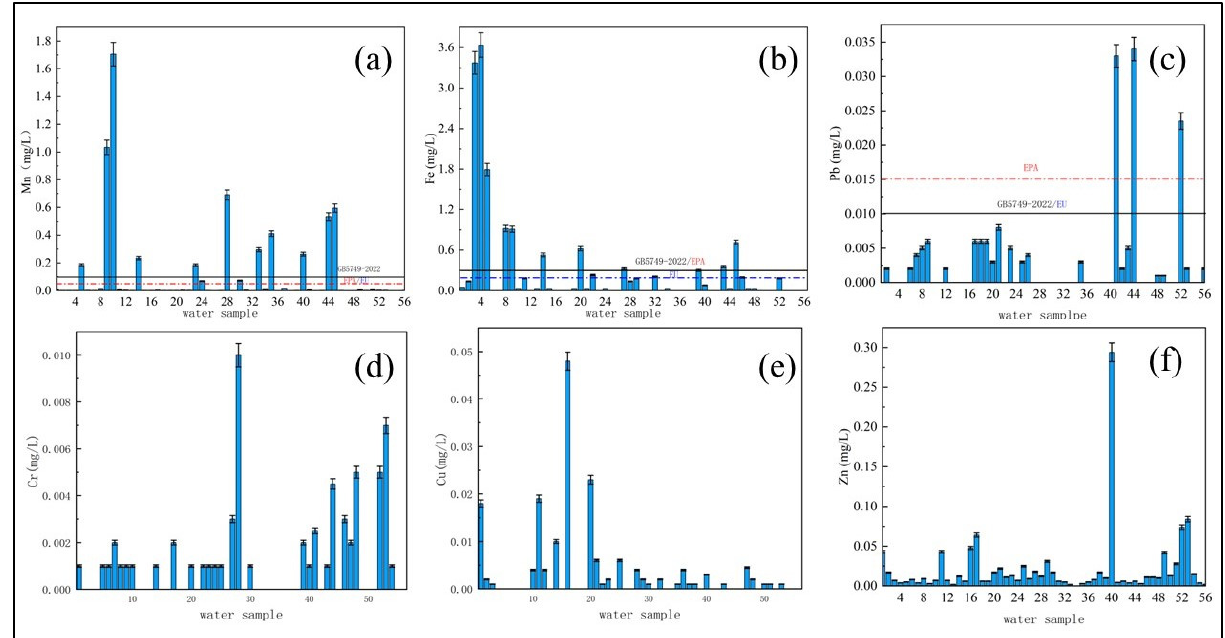
Figure 5. Distribution of heavy metal concentrations in drinking water sources in typical villages and towns in M area: ( a ) Mn, ( b ) Fe, ( c ) Pb, ( d ) Cr, ( e ) Cu and( f ) Zn.